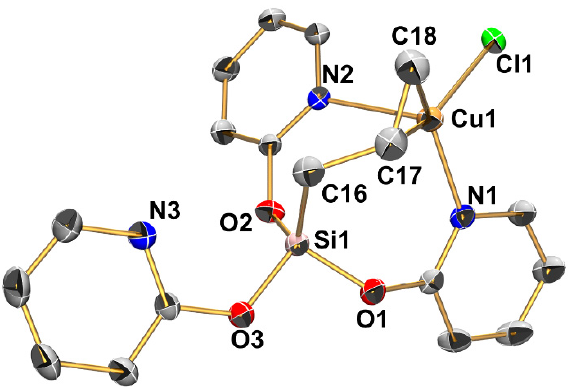
Figure 4. Molecular structure of 2d ′ with thermal displacement ellipsoids at the 50% probability level and labels of selected non-hydrogen atoms. Hydrogen atoms are omitted for clarity. Selected interatomic distances (Å) and angles (deg): Cu1 − Cl1 2.270(1), Cu1···Si1 3.302(1), Cu1 − N1 2.047(2),